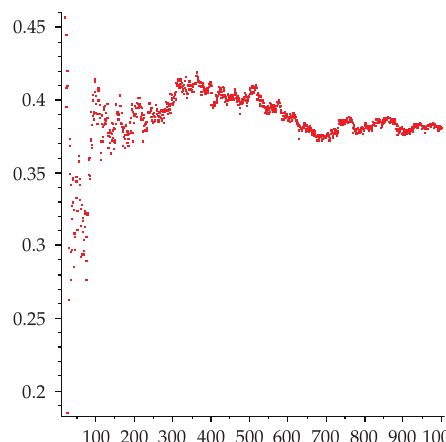
Figure 14: (cid:2) t,λ (cid:2) t (cid:3) /t (cid:3) the Lyapunov exponent in the deterministic case for d (cid:7) 0 .